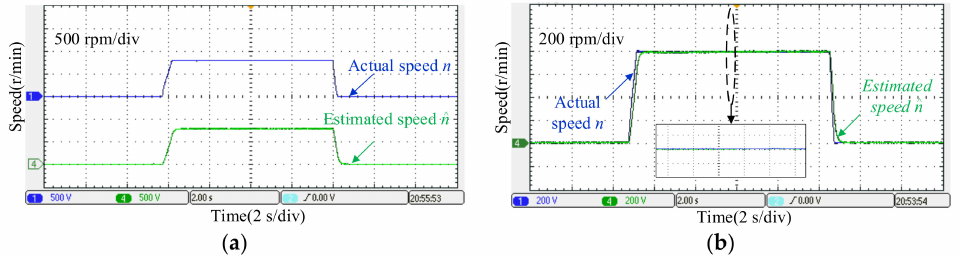
Figure 14. Actual speed and estimated speed employing the proposed full-order SMO method based on SFT filter when the motor operates at 800 rpm. ( a ) separated waveform; ( b ) overlapped waveforms.